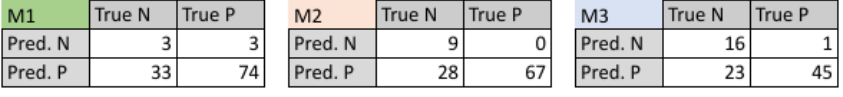
Figure 4. Confusion matrices for the SVM classifier.